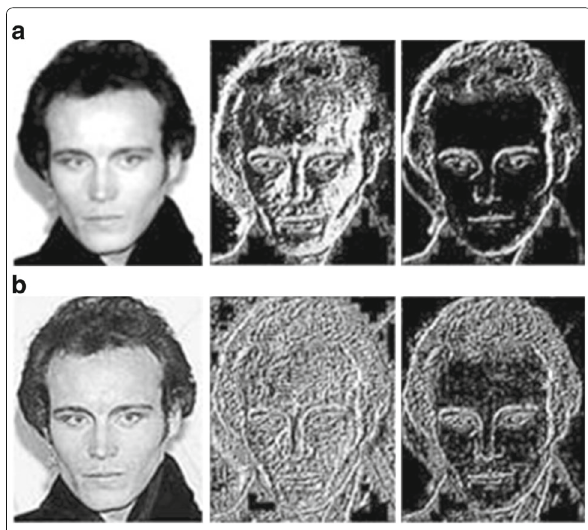
Fig. 9 Noise resistance of CENTRIST vs. DTCTH. a Image without noise. b Noisy image ( middle one is CENTRIST-coded image, right one is DTCTH-coded